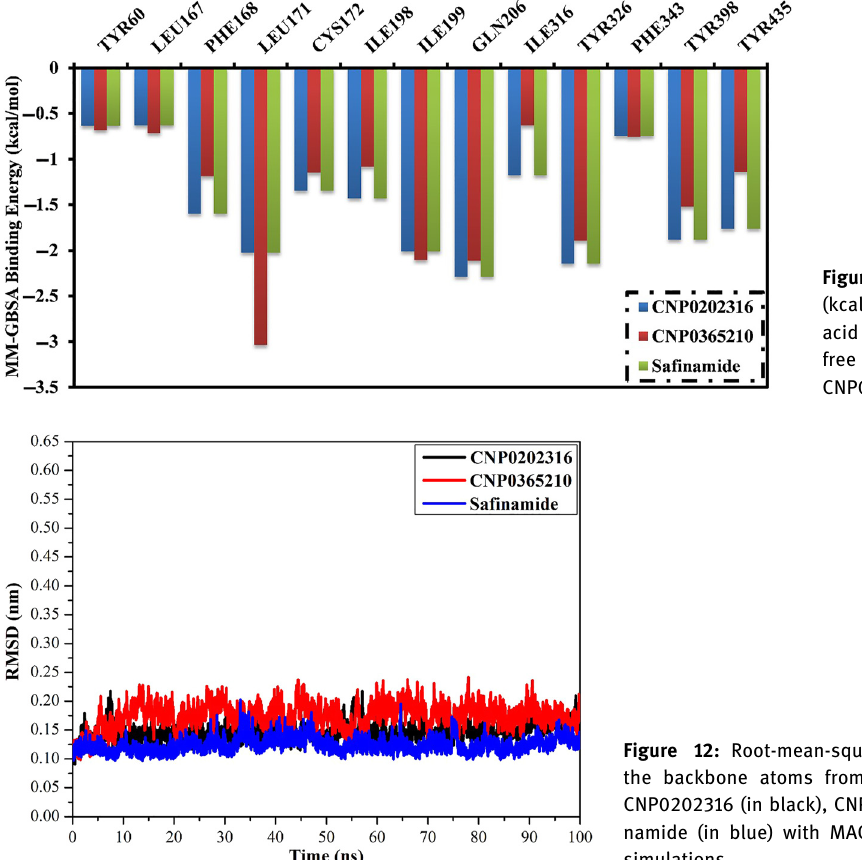
Figure 12: Root-mean-square deviation (RMSD) of the backbone atoms from the starting structure of CNP0202316 (in black), CNP0365210 (in red), and safi- namide (in blue) with MAO-B during the 100 ns MD